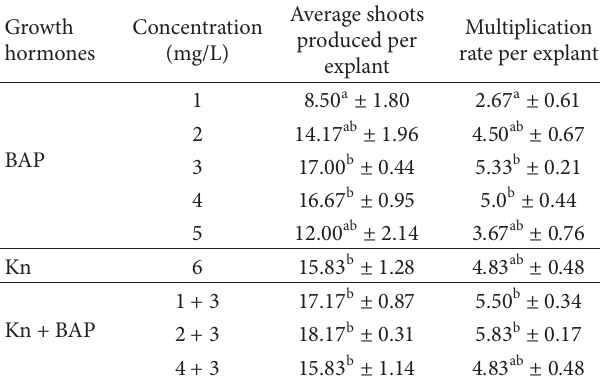
Table 2: Effect of BAP, Kn, and Kn + BAP in MS medium on shoot multiplication of Melocanna baccifera